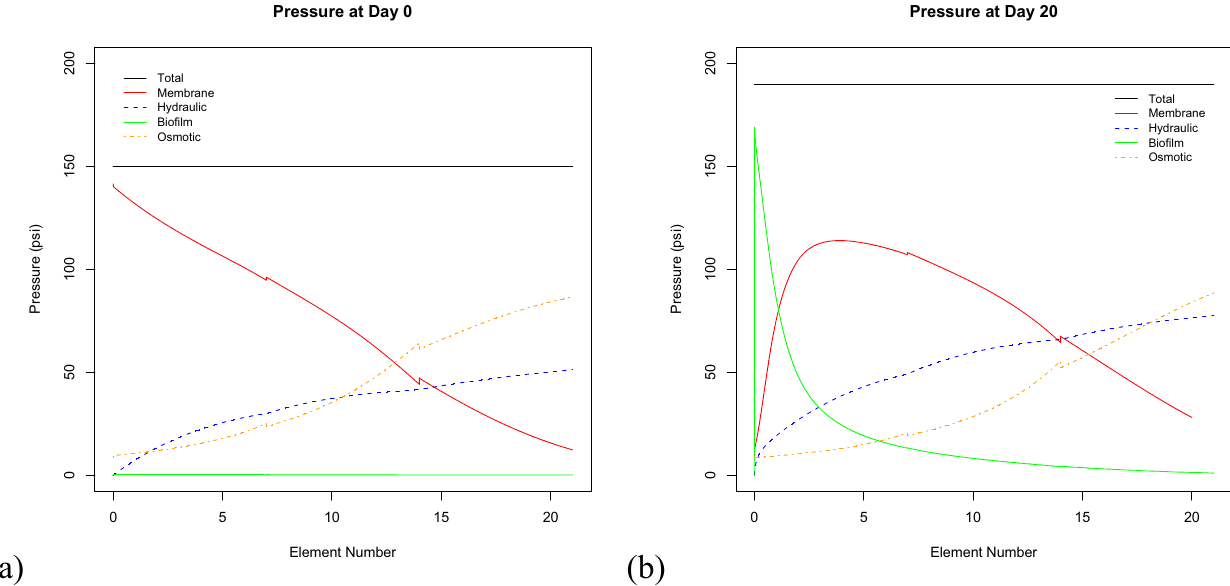
Fig. 9 Model illustration of local pressure pro fi les before and after bio fi lm formation. Local pressure drops on day 0 ( a ) and day 20 ( b ) from inlet to outlet of the RO system illustrating the drop in trans-membrane pressure (TMP) at the inlet where the bio fi lm initially forms and the shift in TMP downstream as the bio fi lm pressure drop grows from the plant inlet downstream over